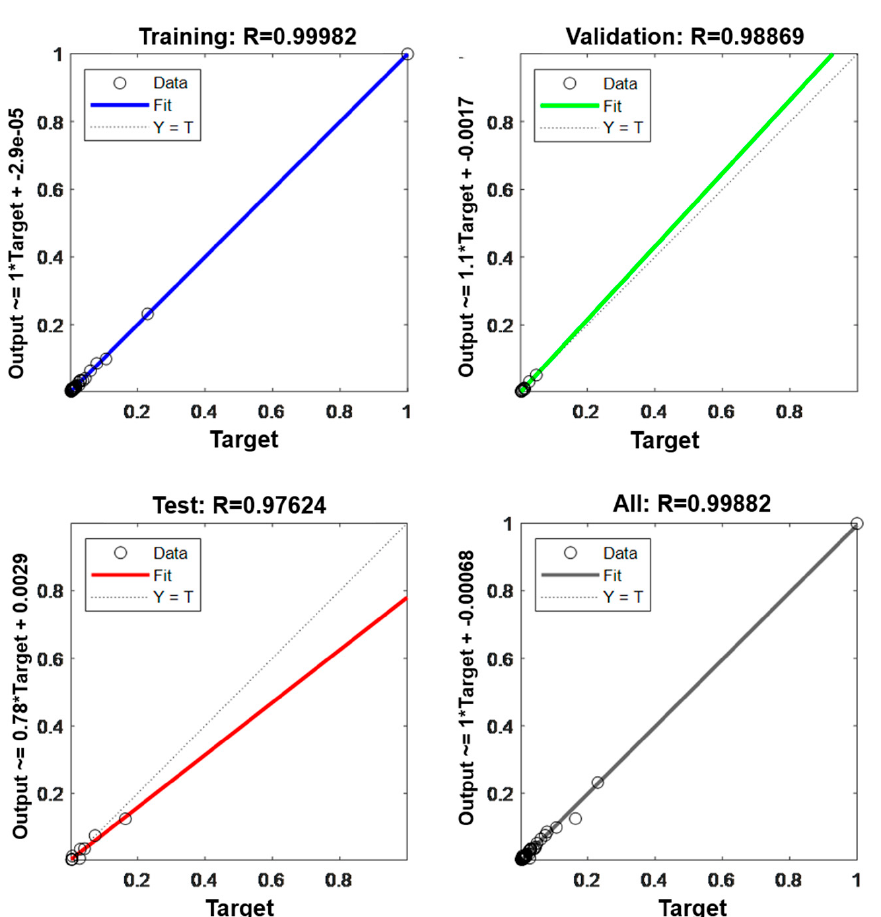
Figure 4. The correlation coefficient R for training analysis of an ANN with four variables in the input layer, and two hidden layers with nine neurons each. Table 5. ANN architectures and their performance for the simulation